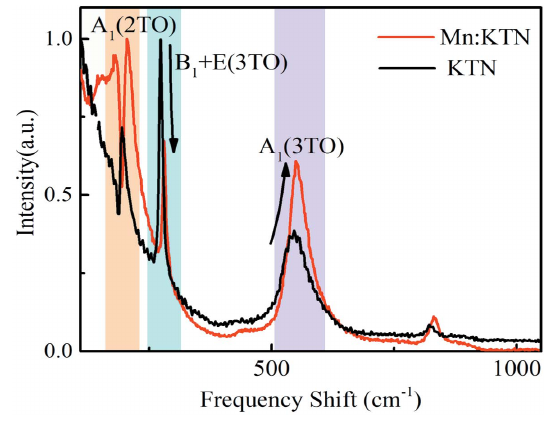
Figure 3 Raman spectra of Mn-doped and pristine KTN in VH